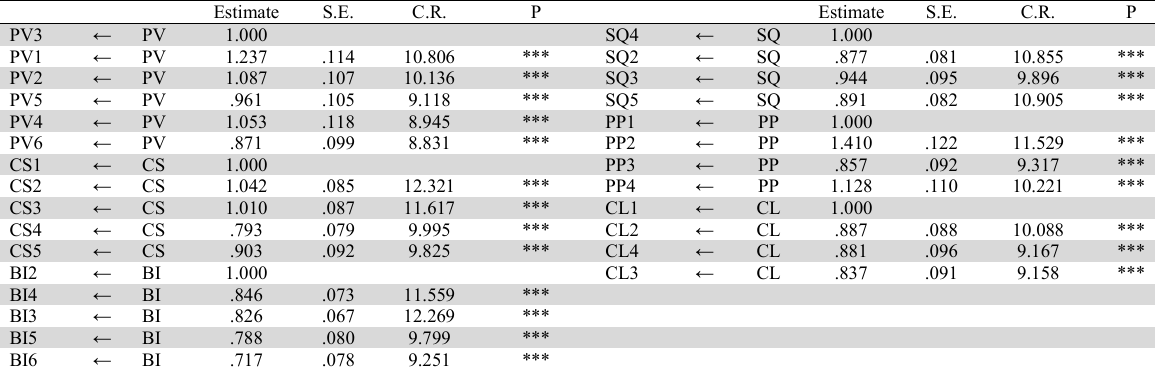
Regression weight (CFA)